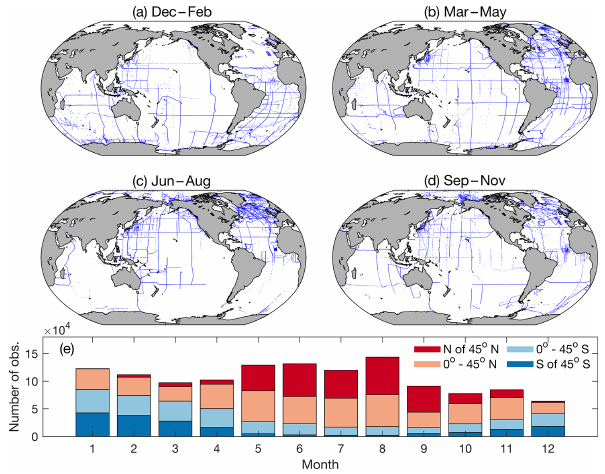
Figure 10. Distribution of data in GLODAPv2.2020 in (a) December–February, (b) March–May, (c) June–August, (d) September–November, and (e) number of observations for each month in four latitude bands.